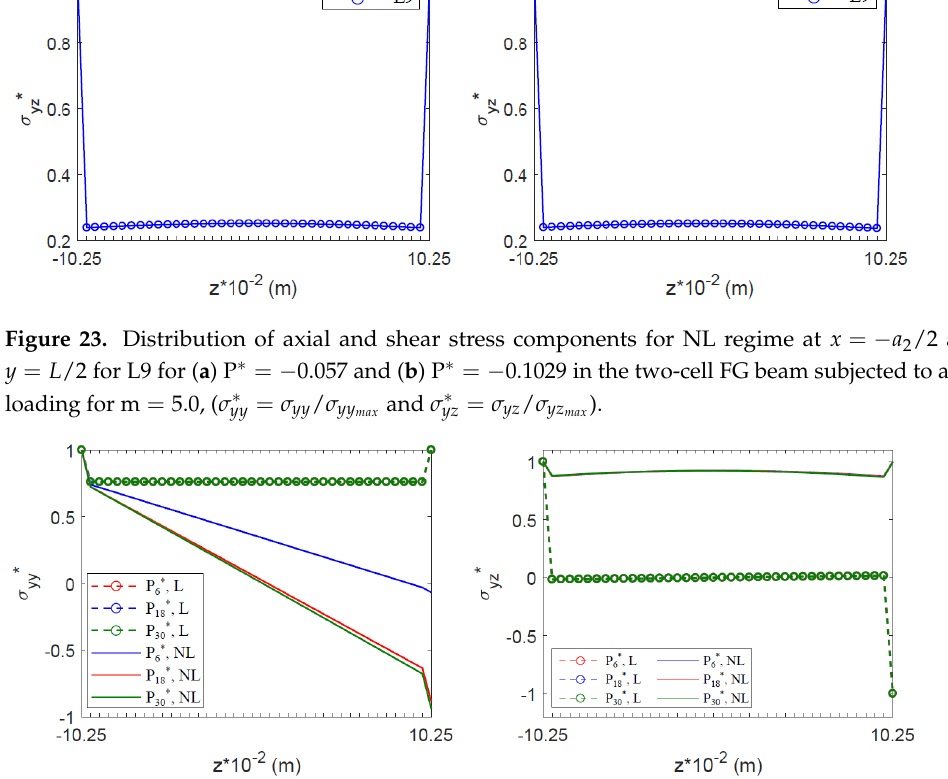
and σ ∗ yz = σ yz / σ yz max max